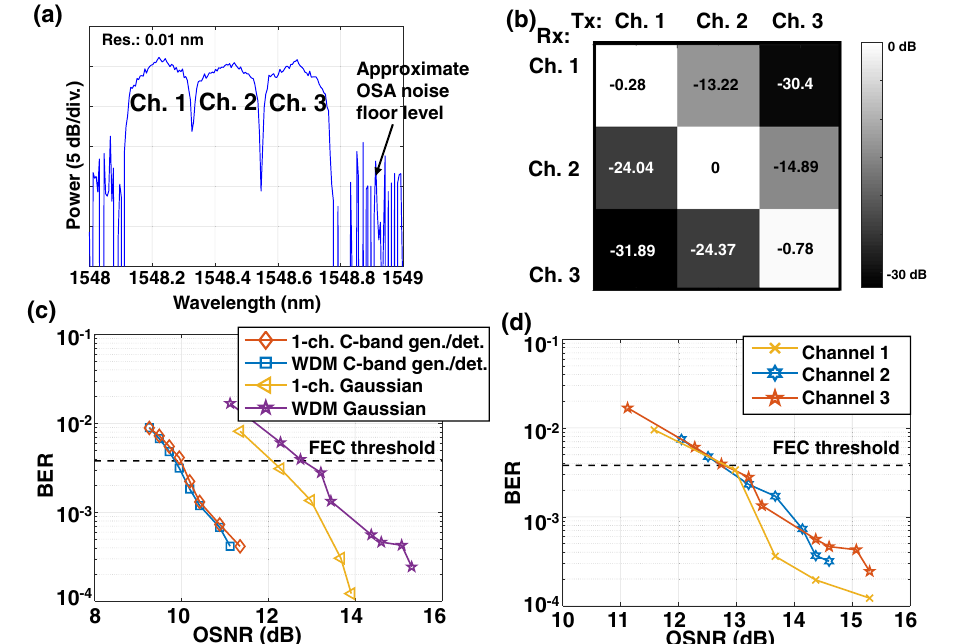
Fig. 4 | Demonstration of a three-channel mid-IR WDM FSO communication system with the Gaussian beam. a Spectrum of the WDM signals that are con- verted back to the C-band. b Normalized optical crosstalk matrix of WDM. c Measured biterror rate (BER)asa function of the received opticalsignal-to-noise ratio (OSNR) for a C-band generation/detection (gen./det.) and mid-IR Gaussian